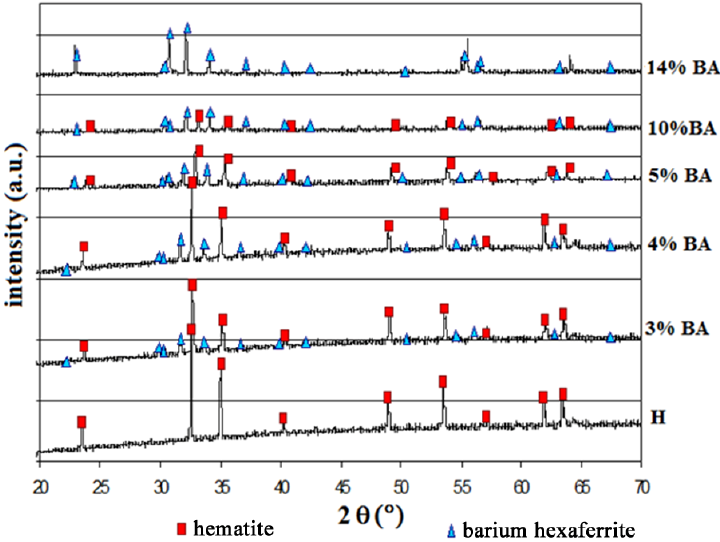
Figure 1. XRD spectra of various barium-doped hematite samples.